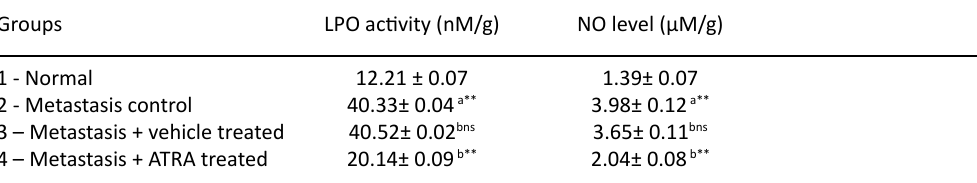
table 4. Extent of lipid peroxidation and Nitric Oxide levels in the lung tissue Groups